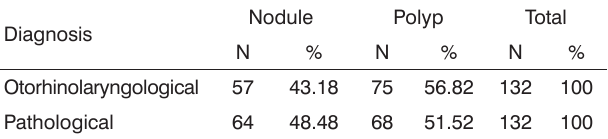
Table 2. Number and percentage distribution of ENT and pathology diagnoses of vocal fold nodules and polyps.